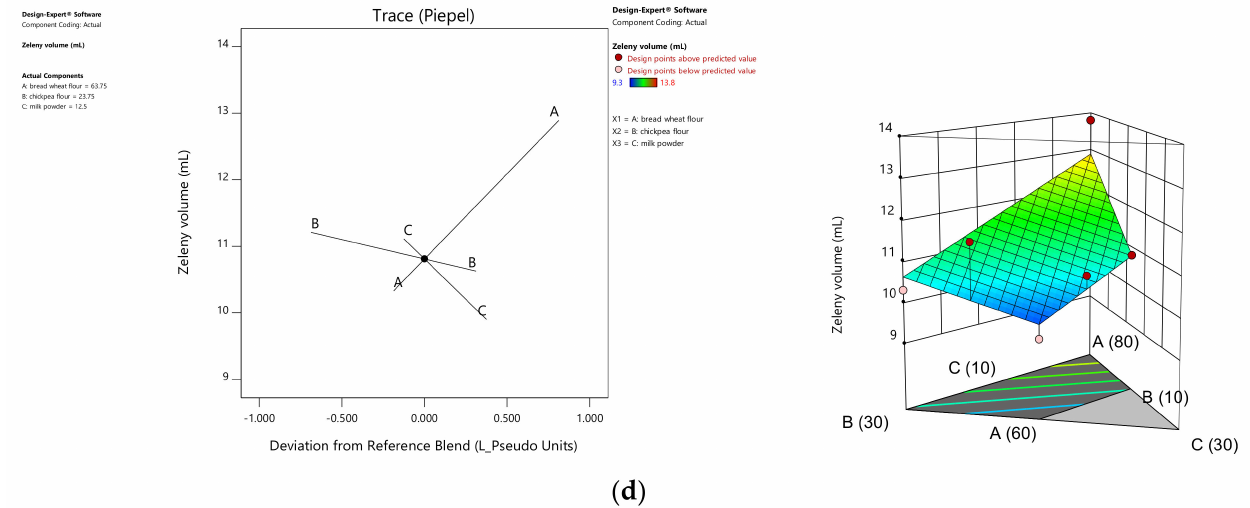
Figure 3. Trace plot curves and response surface (2D and 3D) presentations of total phenolic content ( a ), scavenging activity ( b ), zeleny volume ( c ), and yellow index ( d ) variation in flour blends (A: Bread Wheat, B: Chickpea, C: Milk